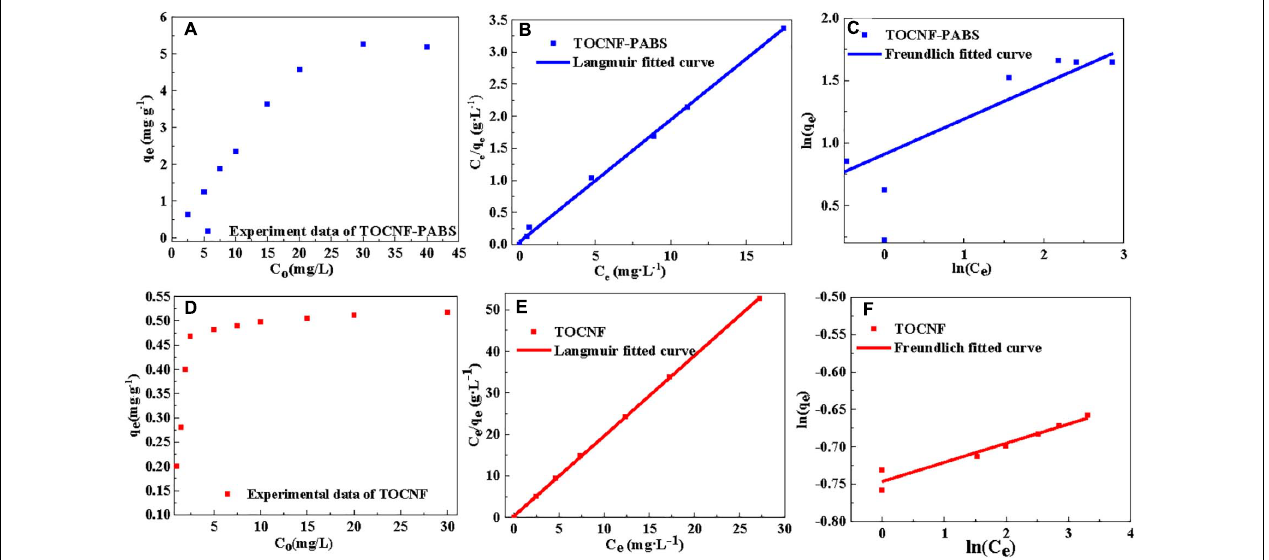
FIGURE 4 | Linear fitting curves of isotherm models (Langmuir and Freundlich models) for the adsorption of Cr(VI) onto TOCNF and TOCNF-PABS. (A) Effect of different initial Cr(VI) concentration on the adsorption capacity of TOCNF-PABS; (B) Linear fitting curve of Langmuir model for the adsorption of Cr(VI) onto TOCNF-PABS; (C) Linear fitting curve of Freundlich model for the adsorption of Cr(VI) onto TOCNF-PABS; (D) Effect of different initial Cr(VI) concentration on the adsorption capacity of TOCNF; (E) Linear fitting curve of Langmuir model for the adsorption of Cr(VI) onto TOCNF; (F) Linear fitting curve of Freundlich model for the adsorption of Cr(VI) onto TOCNF.